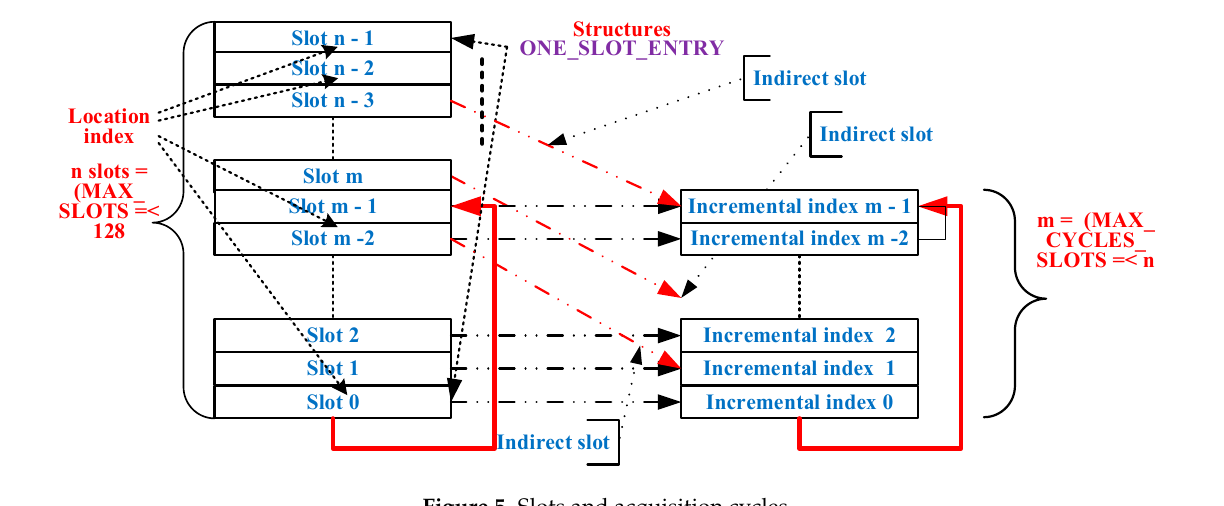
Figure 5. Slots and acquisition cycles.